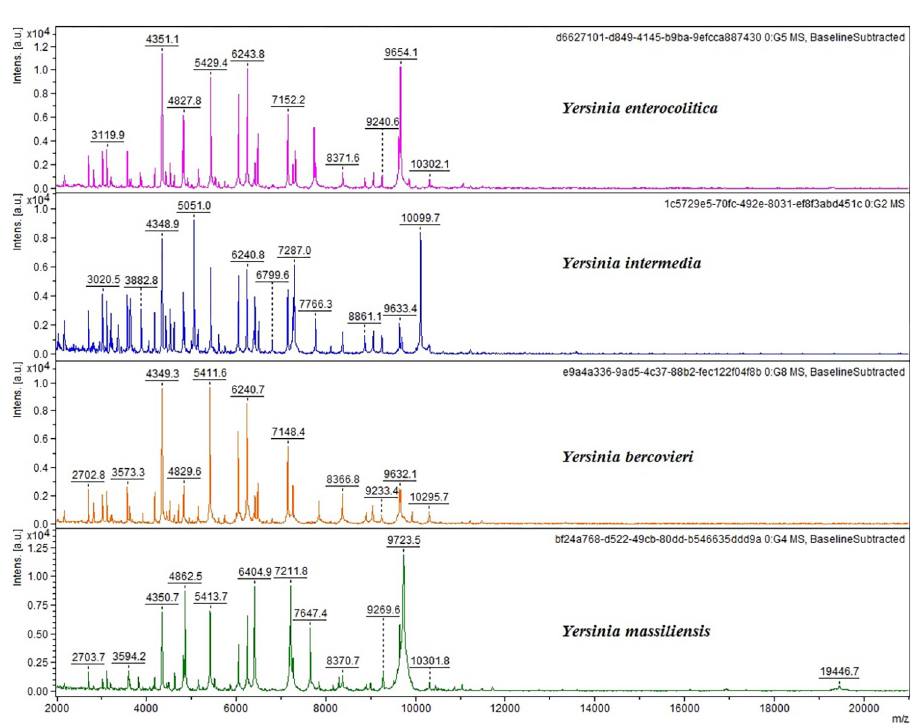
Fig 1. MALDI-TOF mass spectra of four Yersinia species in the mass range of 2 to 20 kDa: Y enterocolitica , Y . intermedia , Y . bercovieri , Y massiliensis . The mass spectra were obtained using the FlexAnalysis software (v. 3.4, Bruker Daltonik GmbH, Bremen, Germany), performing baseline corrected, smoothed and normalized